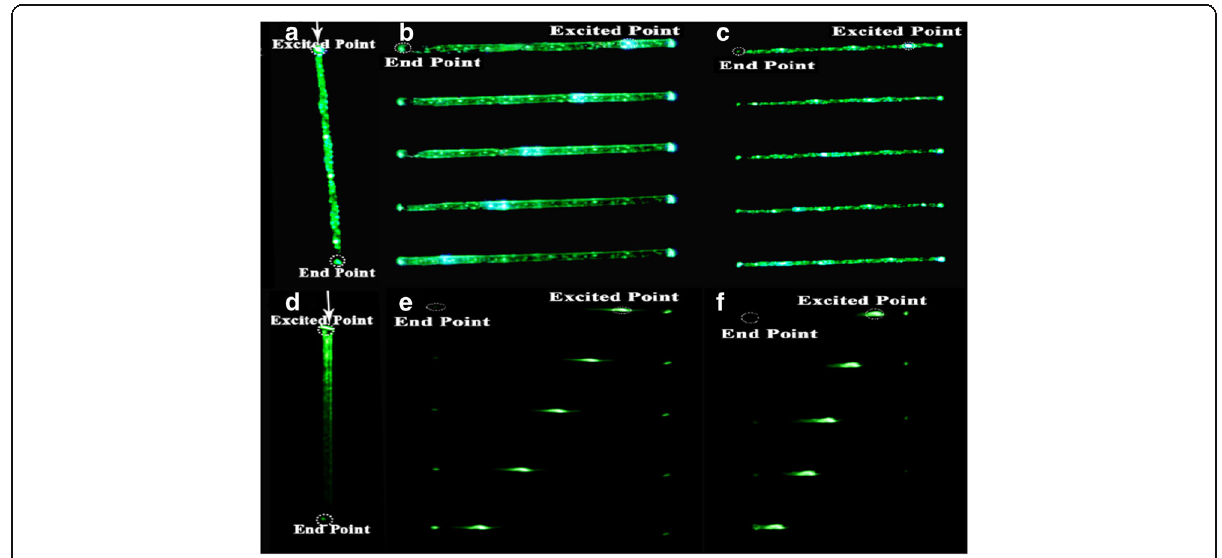
Fig. 6 Photoluminescence images with different diameter of microfibers. a – c Luminescence of Ag microfiber under dark background. d – f Excitation without Ag microfiber under black